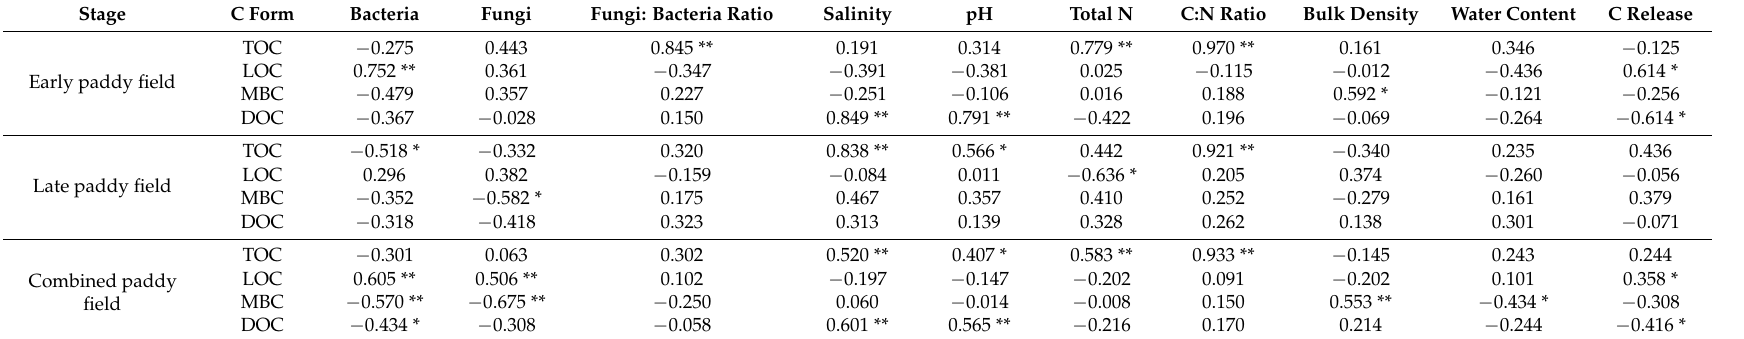
Table 1. Pearson correlation coefficients between the concentrations of different carbon forms and various soil properties.